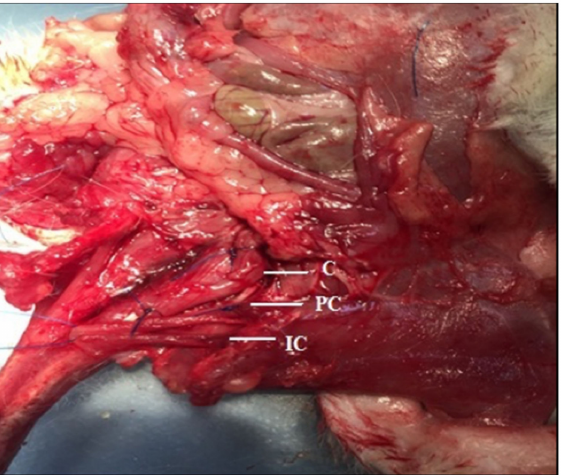
Figure 1. Rat left m. iliocaudalis (IC), m. pubocaudalis (PC) and m. coccygeus (C)